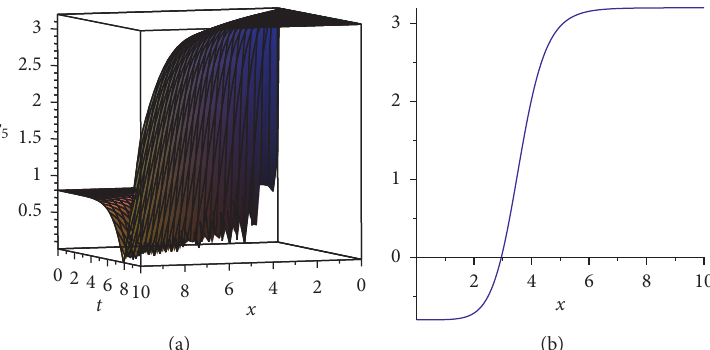
( t,x ) at A � B � − 2, a � 2, α � ( 1/2 ) , β � ( 1/3 ) , k � 2, ξ 5